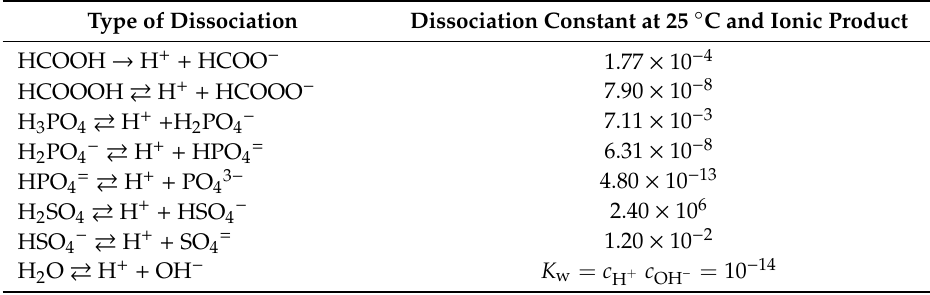
Table 3. Ionic dissociation constants at 25 ◦